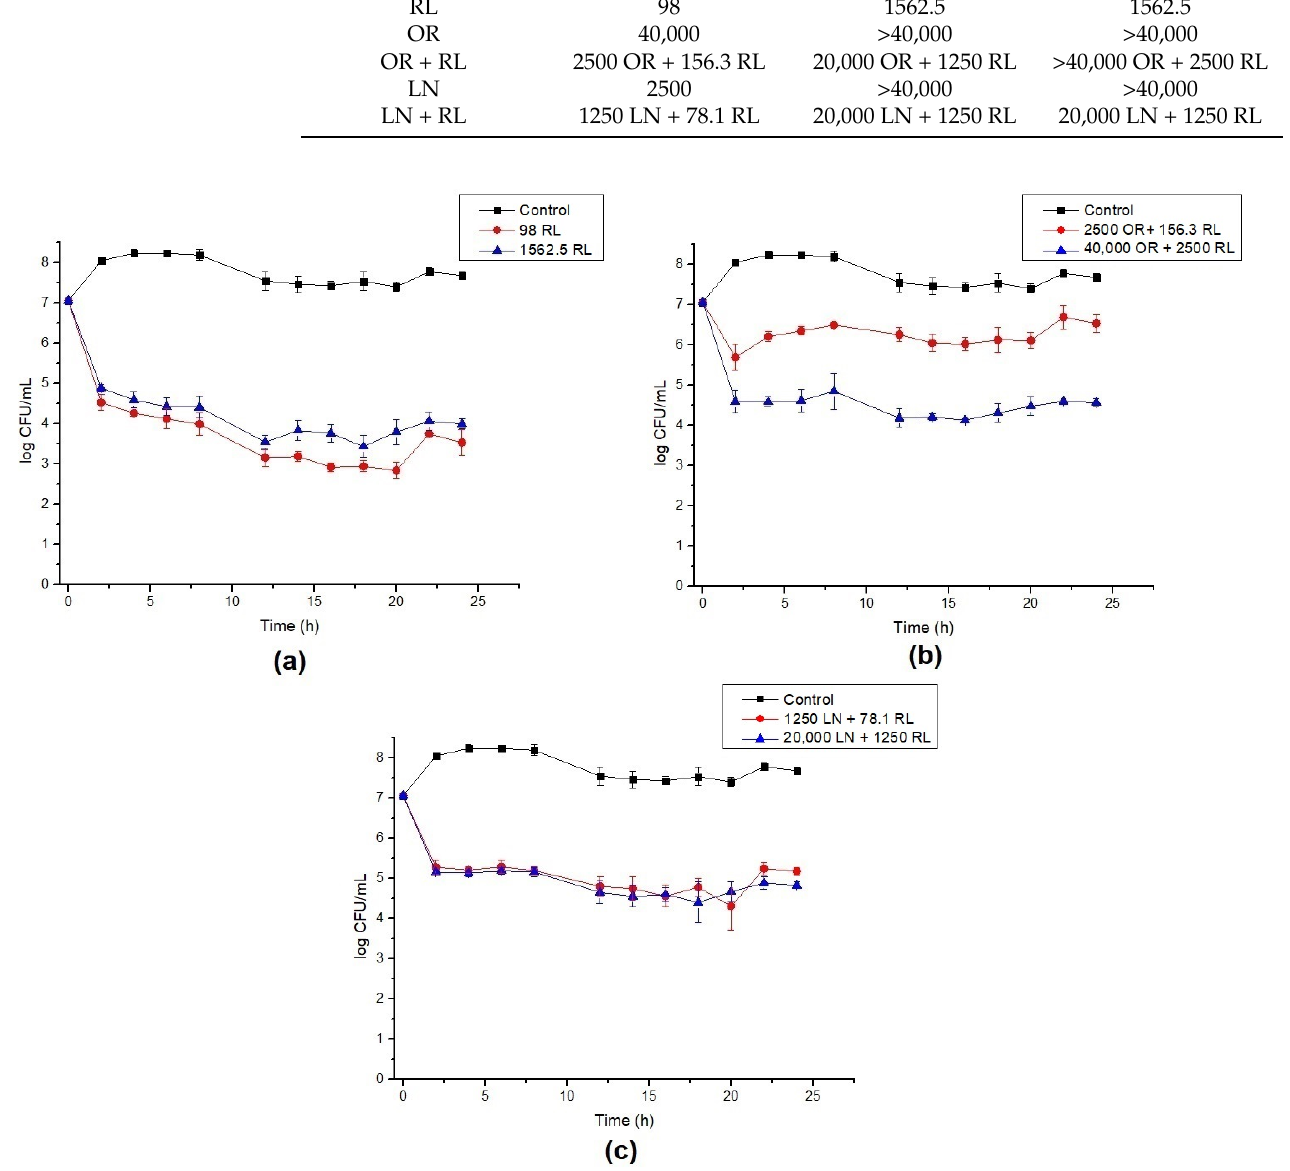
Figure 3. Percentage of B. cereus endospore germination inhibition of RL, OR + RL, and LN + RL treatments. The concentrations used for this experiment were 16× and 32× MIC. Error bars represent